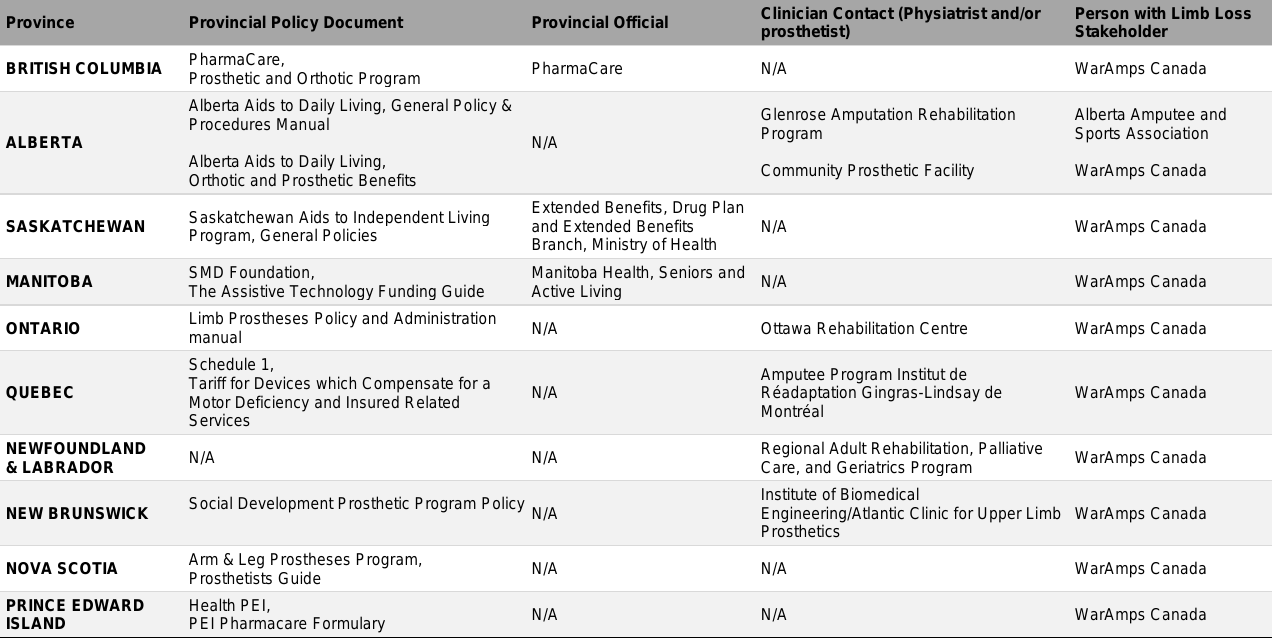
Table 1 : Sources of prosthetic device coverage information by province and source